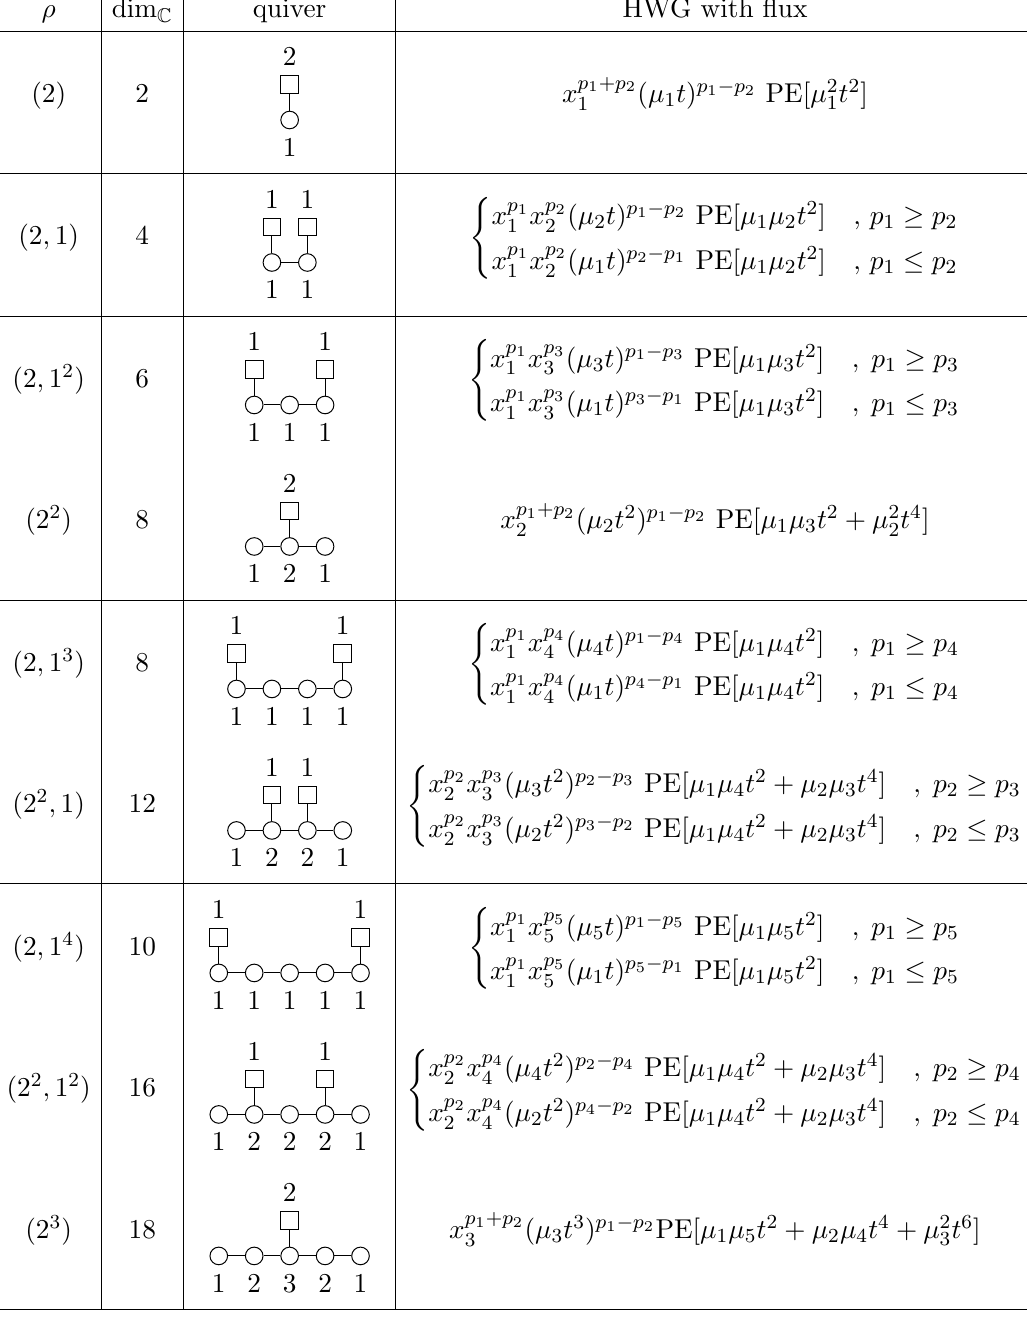
Table 3 . Coulomb branch quiver gauge theories for A-type algebras: gauge theories T (cid:26) T [SU( n +1)] as Coulomb branch realisations of the (closures of the) nilpotent orbits O (cid:26) of A n , for n = 1 ; 2 ; 3 ; 4 ; 5. The unphysical U(1) in G F can be eliminated in the HWG by imposing that the sum of (cid:13)uxes vanishes. In more detail, the U(1) could be counted by an auxiliary fugacity z 0 and one can impose z p k + p n +1 (cid:0) k